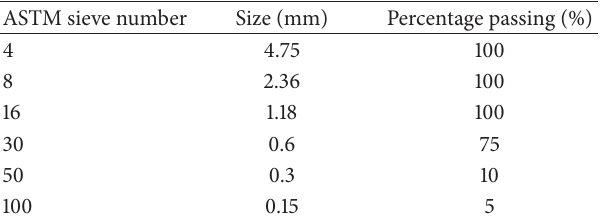
Table 2: Grading of the dune sand used as